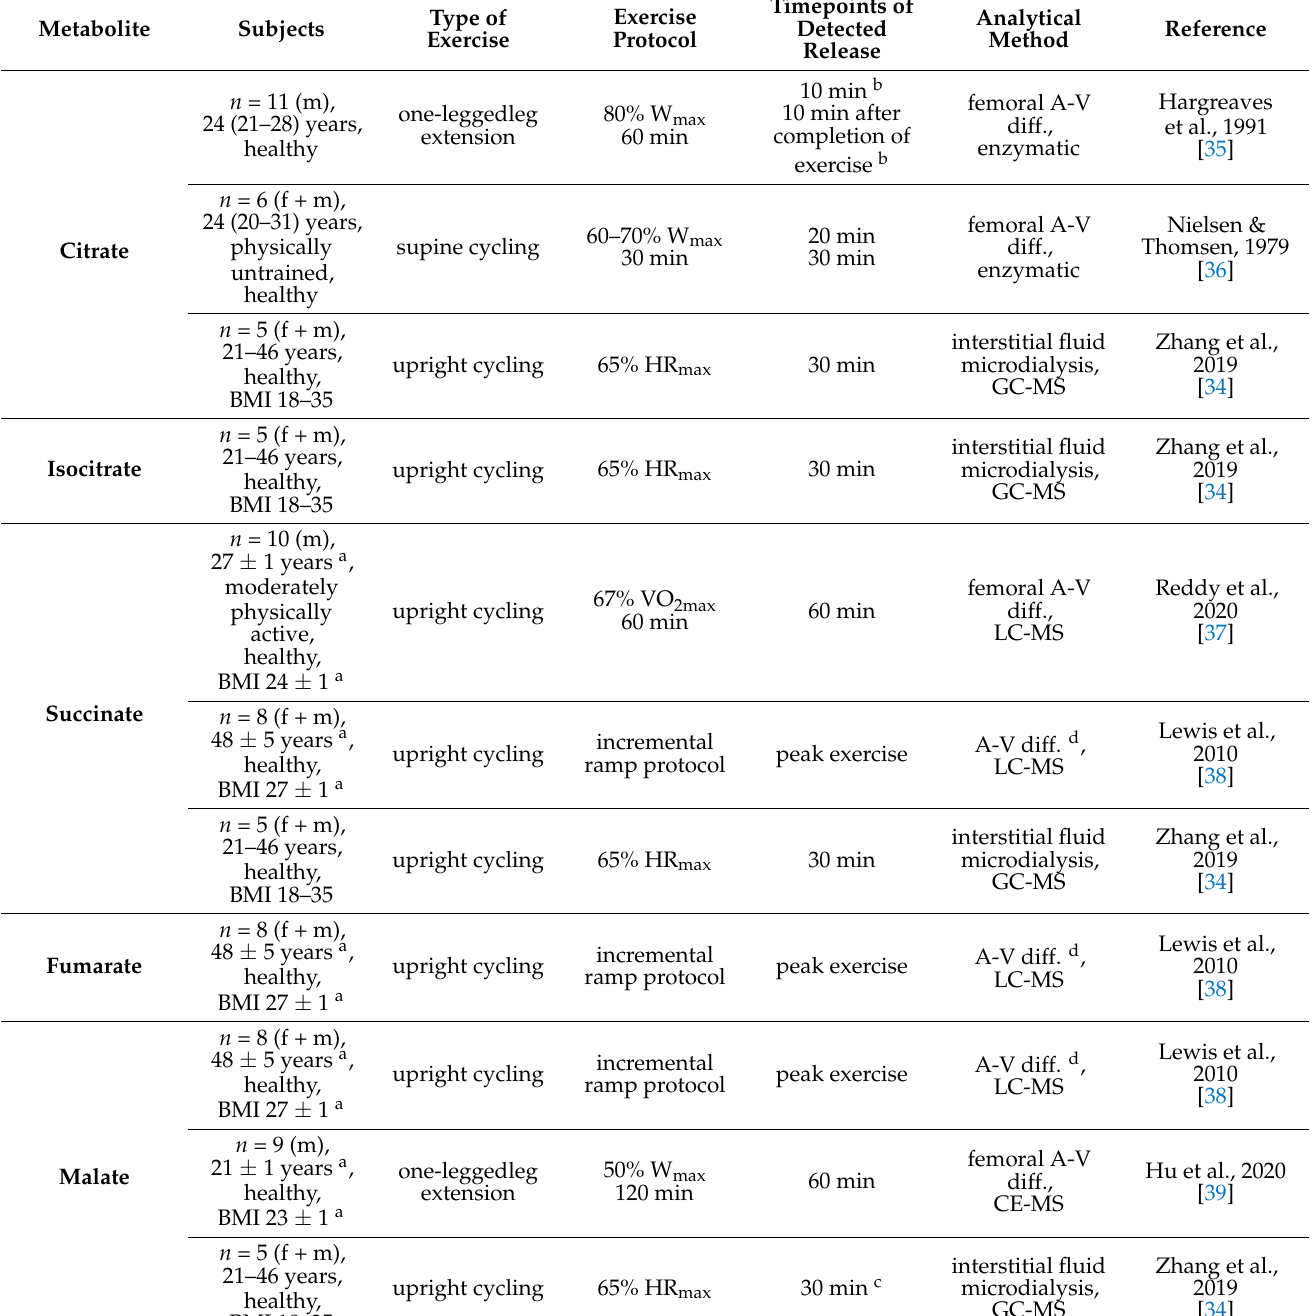
Table 1. TCA intermediates released by human skeletal muscle during endurance